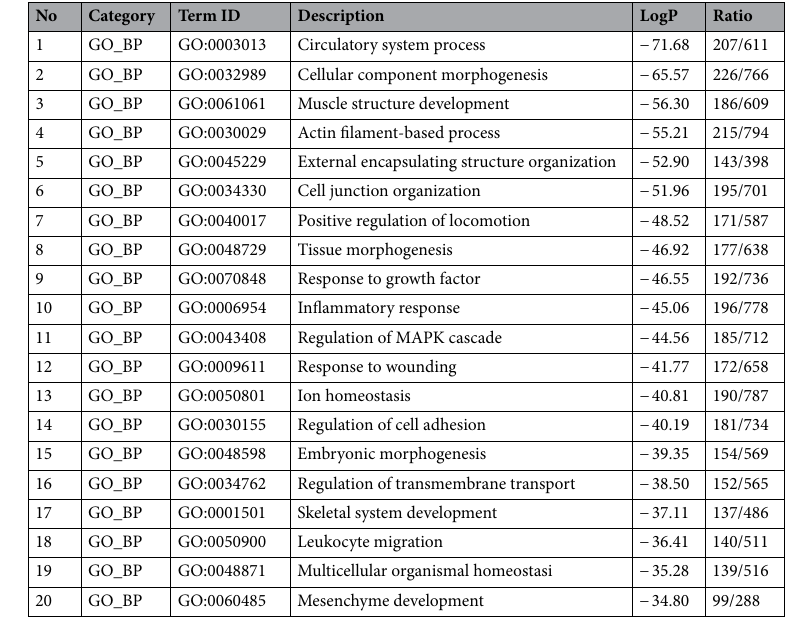
Table 2. Functional annotation of GO_BP for top20 of four sets of